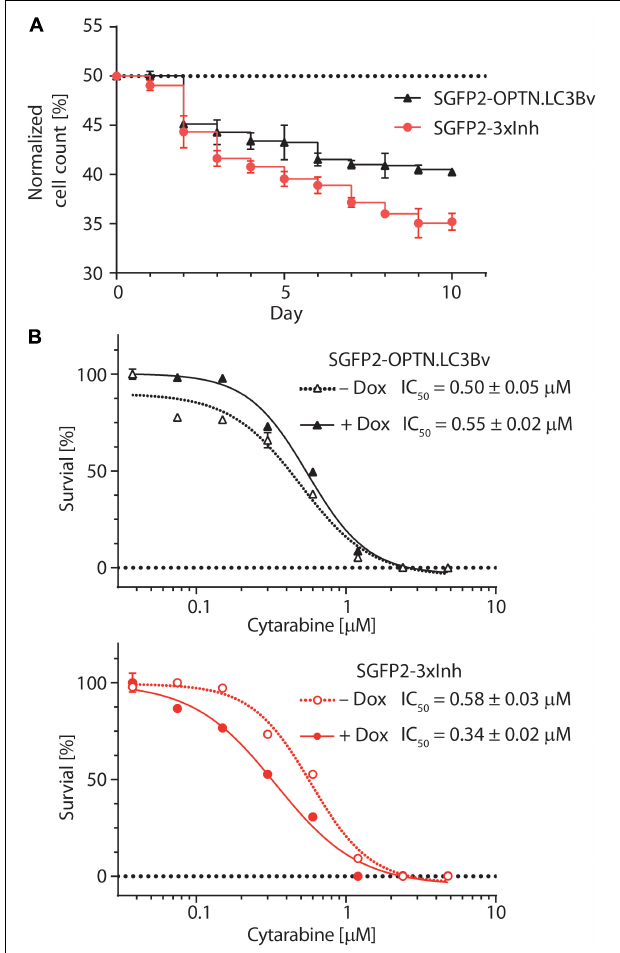
FIGURE 5 | Engineered LC3B and GATE-16 variants reduce growth and sensitize THP-1 AML cells to cytarabine treatment. (A) Competitive growth of lentivirally transduced THP-1 cells stably and inducibly expressing SGFP2-OPTN.LC3Bv (black) or SGFP2-OPTN.LC3Bv-p62.GATE-16v-NDP52.LC3Bv (3xInh, red) in relation to similarly transduced THP-1 cells expressing mCherry fusion of LC3Bwt or a triple control construct of LC3Bwt-GATE-16wt-LC3Bwt. Cells transduced with inhibitor construct and corresponding controls were mixed 1:1 and monitored by FACS every 24 h over 10 days. Expression of the transgenes was induced with doxycycline (Dox, 0.8 µ g/mL). Percentage of cells expressing SGFP2 inhibitor construct is plotted for each day. Error bars correspond to standard deviation (SD) of three independent replicates ( n = 3). (B) Percent survival of THP-1 cells transduced with sGFP2-OPTNLC3Bv (upper panel) or sGFP2-OPTN.LC3Bv-p62.GATE-16v-NDP52.LC3Bv (3xInh, lower panel) in response to increasing cytarabine concentration in the presence (filled symbols) or absence (open symbols) of doxycycline measured as cellular ATP content by luciferase bioluminescence. Error bars correspond to the SD of three independent replicates ( n = 3). IC 50 was determined by non-linear regression using a standard dose response model (GraphPad Prism